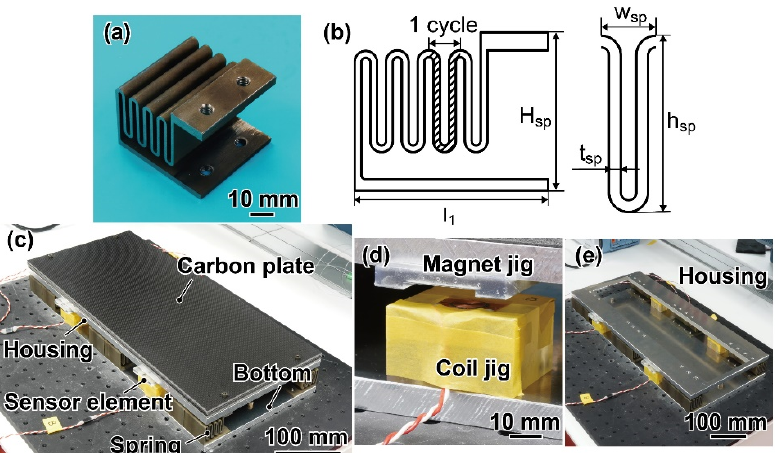
Figure 6. ( a ) Photograph and ( b ) schematic image of the fabricated spring. ( c – e ) Photographs of the fabricated force plate, sensor element, and housing.